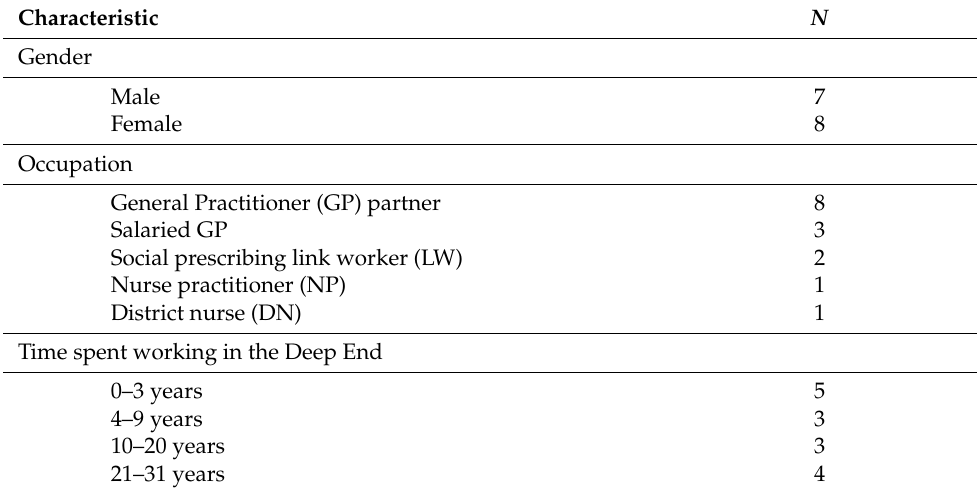
Table 1. Participant